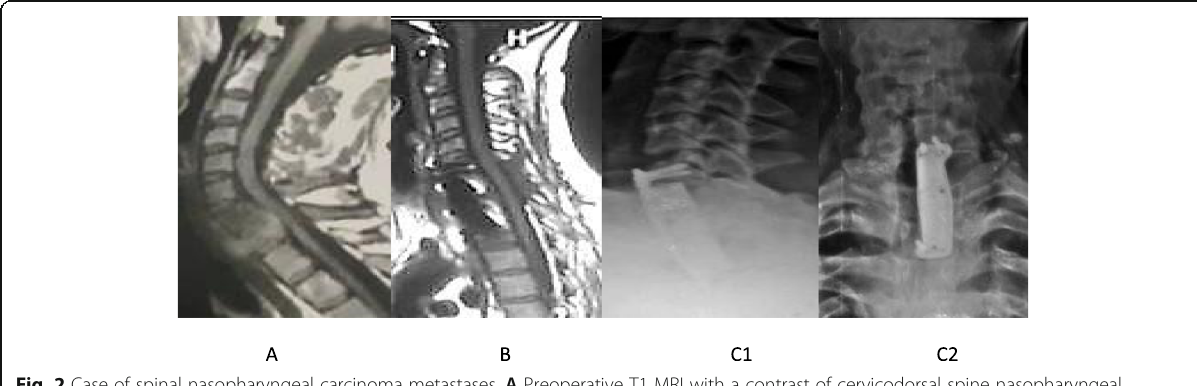
Fig. 2 Case of spinal nasopharyngeal carcinoma metastases. A Preoperative T1 MRI with a contrast of cervicodorsal spine nasopharyngeal carcinoma metastases. B Postoperative T1 MRI with contrast. C1 , C2 Postoperative plain X-ray showing C6-T2 instrumental